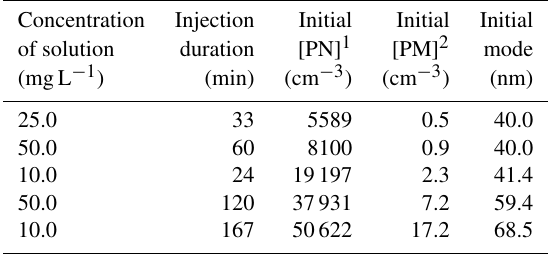
Table 3. Characteristics of the ammonium sulfate experiments. Concentration